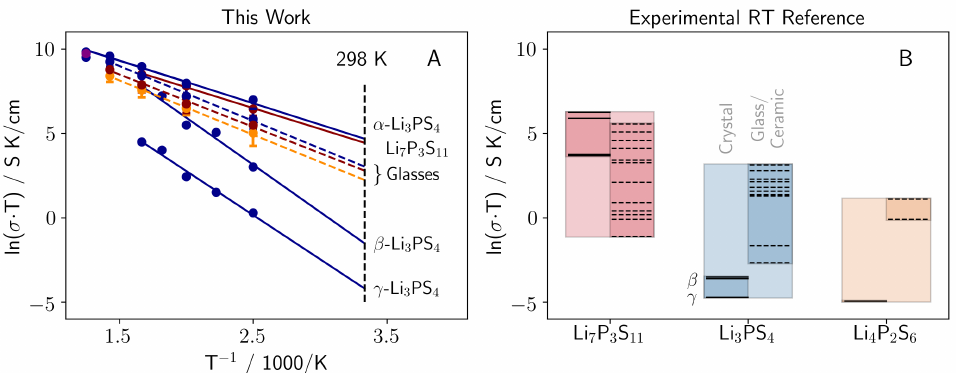
Figure 1. ( A ) Computational Arrhenius plots for Li 7 P 3 S 11 (red solid line) and α , β and γ phase of Li 3 PS 4 (blue solid lines), as well as the glasses of Li 4 P 2 S 6 (orange dashed line), Li 7 P 3 S 11 (red dashed line), and Li 3 PS 4 (blue dashed line). ( B ) Reference conductivity data from literature. A tabulated form including references can be found in Table S3 in the Supplementary Materials. Solid lines refer to nominal crystalline materials, dashed lines to